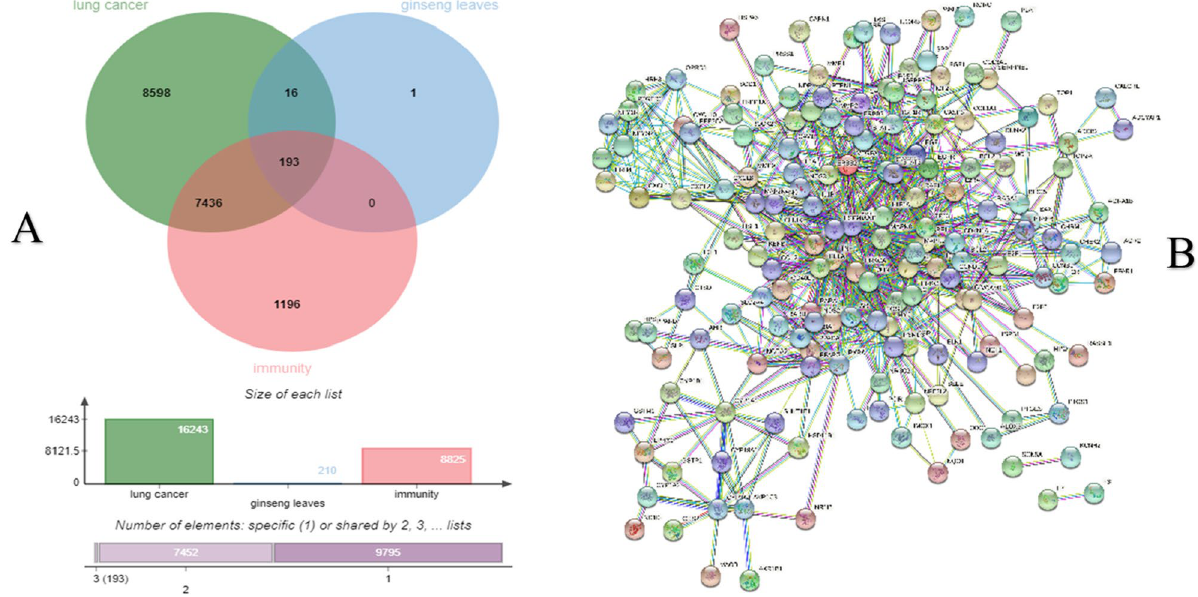
Figure 2. An association network of ginseng leaves targeted proteins associated with lung cancer and immunity. (A) Venn diagram of ginseng leaves, lung cancer and immunity targeted genes. (B) The network for 193 co-targeted genes/proteins had been selected as input for PPI analysis in